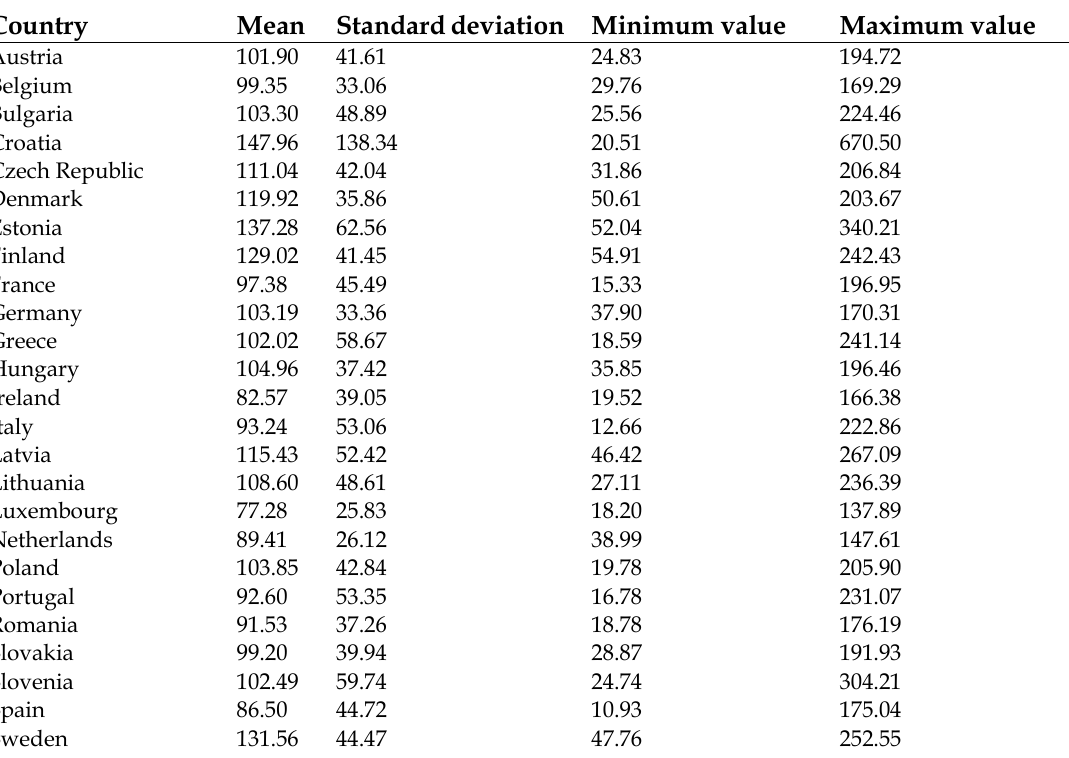
Descriptive statistics for driving percentage changes from 15/02/20 to 15/01/21